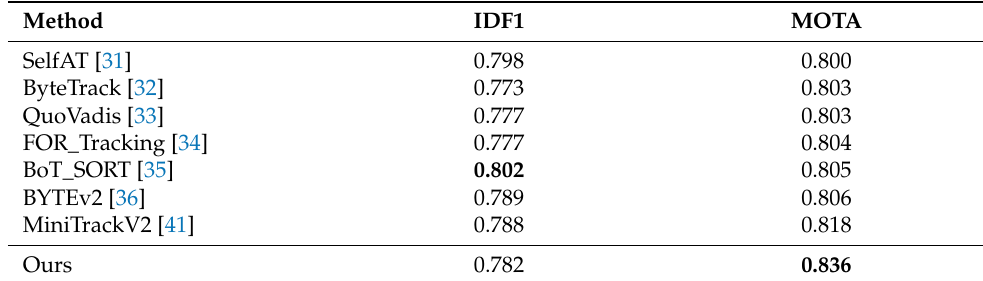
Table 2. Comparison of open algorithm metrics based on MOT17.